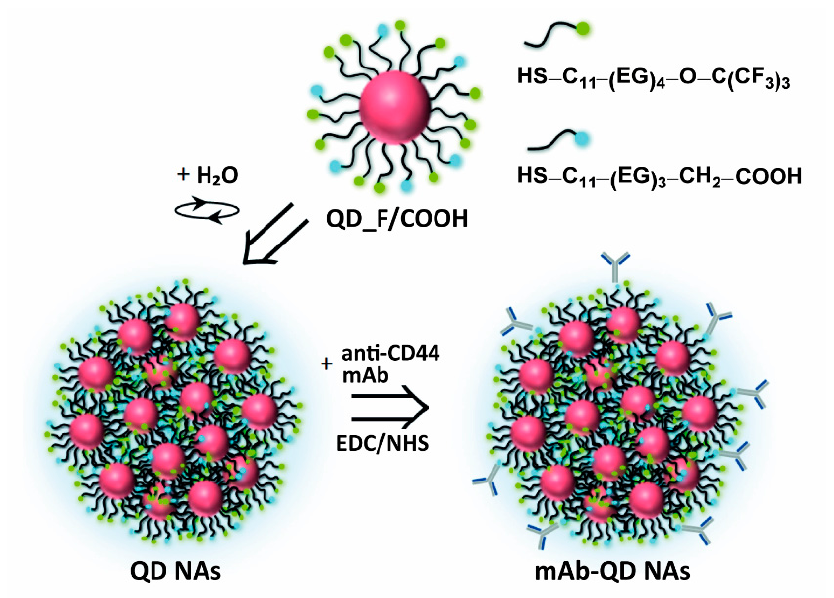
Figure 1. Scheme of the preparation of the mAb-QD NAs based on the self-assembly of QD_F/COOH nanoparticles for obtaining first QD nanoassemblies (QD NAs), and their posterior functionalization with anti-CD44 mAb via EDC chemistry resulting in mAb-QD